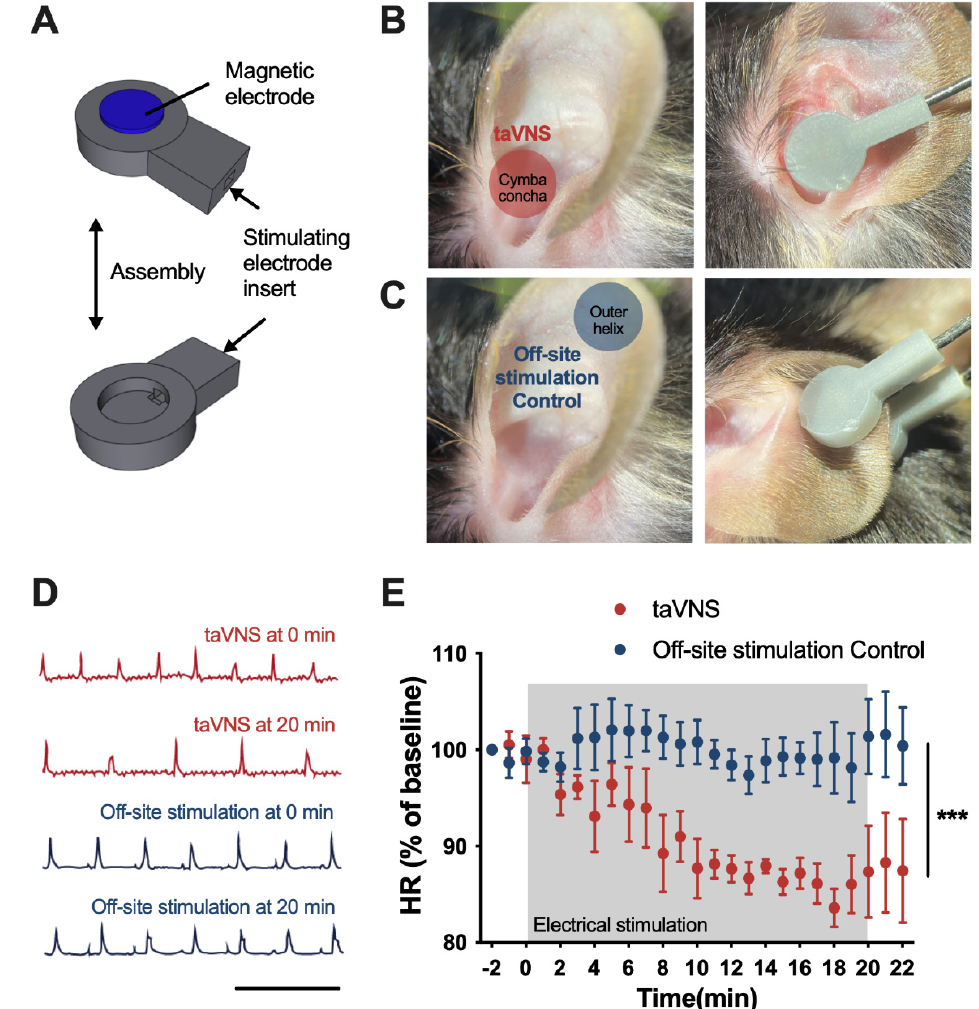
Figure 1. Novel device for auricular vagus nerve stimulation and modulatory effects on heart rates. ( A ) Three-dimensional modeling of stimulation devices. ( B , C ) Three-dimensionally printed prototype device applied to the cymba concha (taVNS) and outer helix (off-site stimulation control). ( D ) Representative ECG trace showing the declined heart rate in a model mouse, corresponding to prolongation of the R-R interval during taVNS. Scale bar 500 ms. ( E ) taVNS suppressed heart rate; however, there were no changes in the off-site stimulation control group (taVNS, n = 5; off-site stimulation control, n = 6; p < 0.001). The error bars indicate the SEM. Two-way repeated measures ANOVA was used. *** p < 0.001.